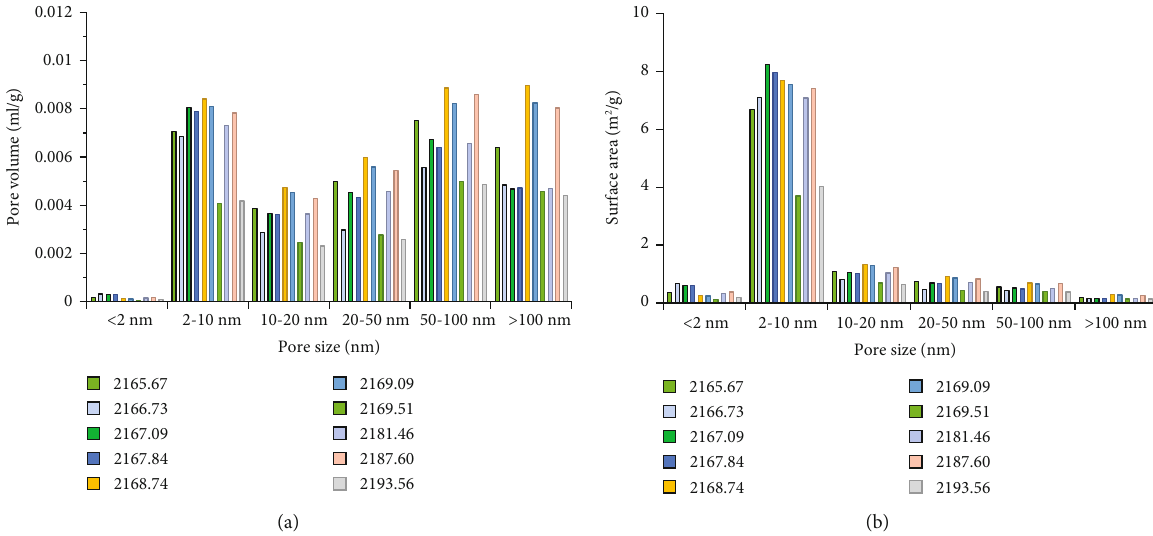
Figure 7: Cumulative pore volume (a) and pore surface area (b) of di ff erent pore diameter ranges for shale samples with di ff erent